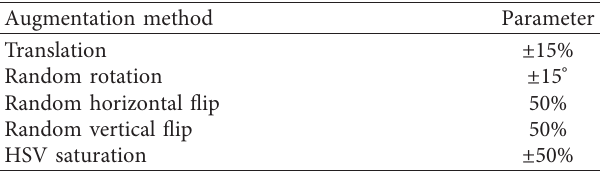
Table 1: Parameters of different data augmentation